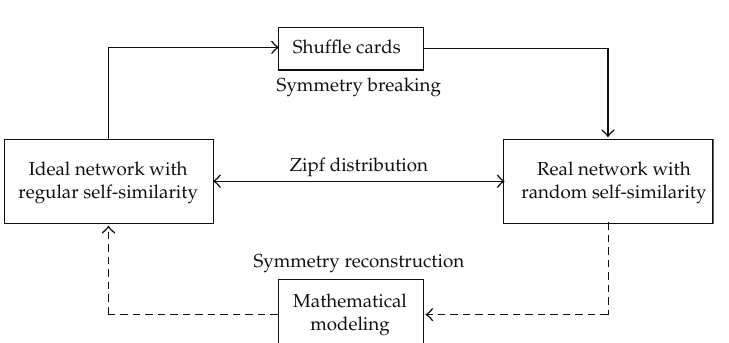
Figure 7: A schematic diagram of symmetry breaking and reconstruction of network of